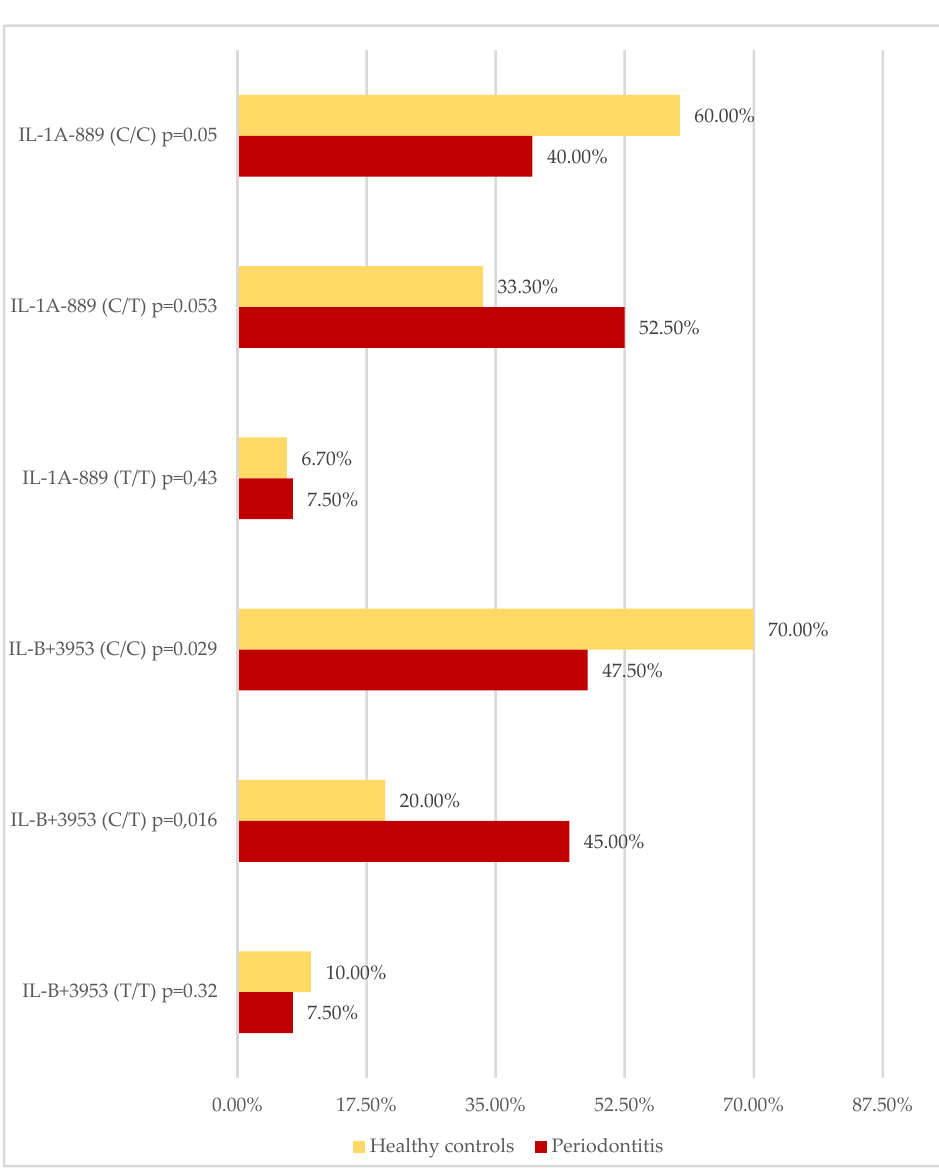
Figure 3. Frequencies of IL-1A − 889 and IL-1B +3953 genotypes in periodontitis patients and healthy controls.